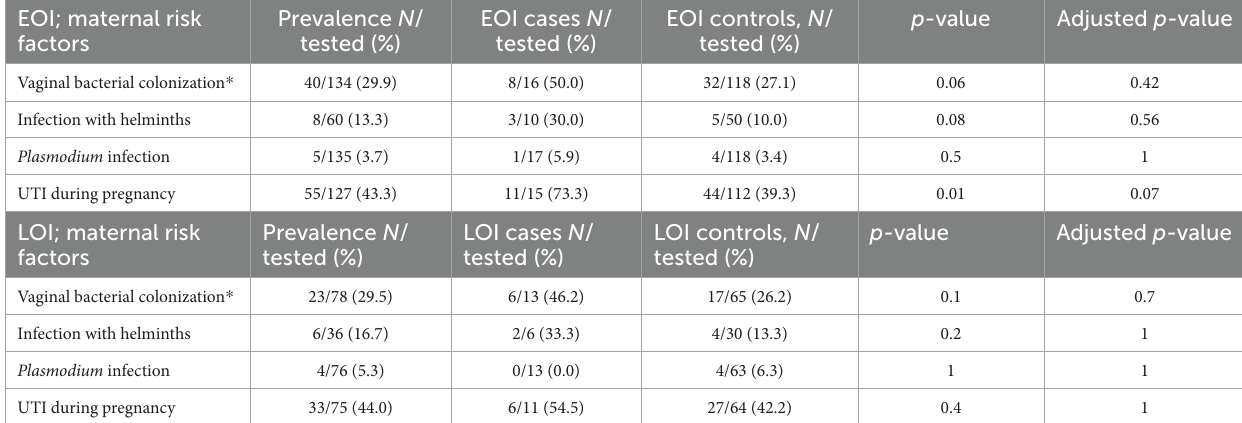
TABLE 3 Prevalence of maternal risk factors for proven/probable EOI and